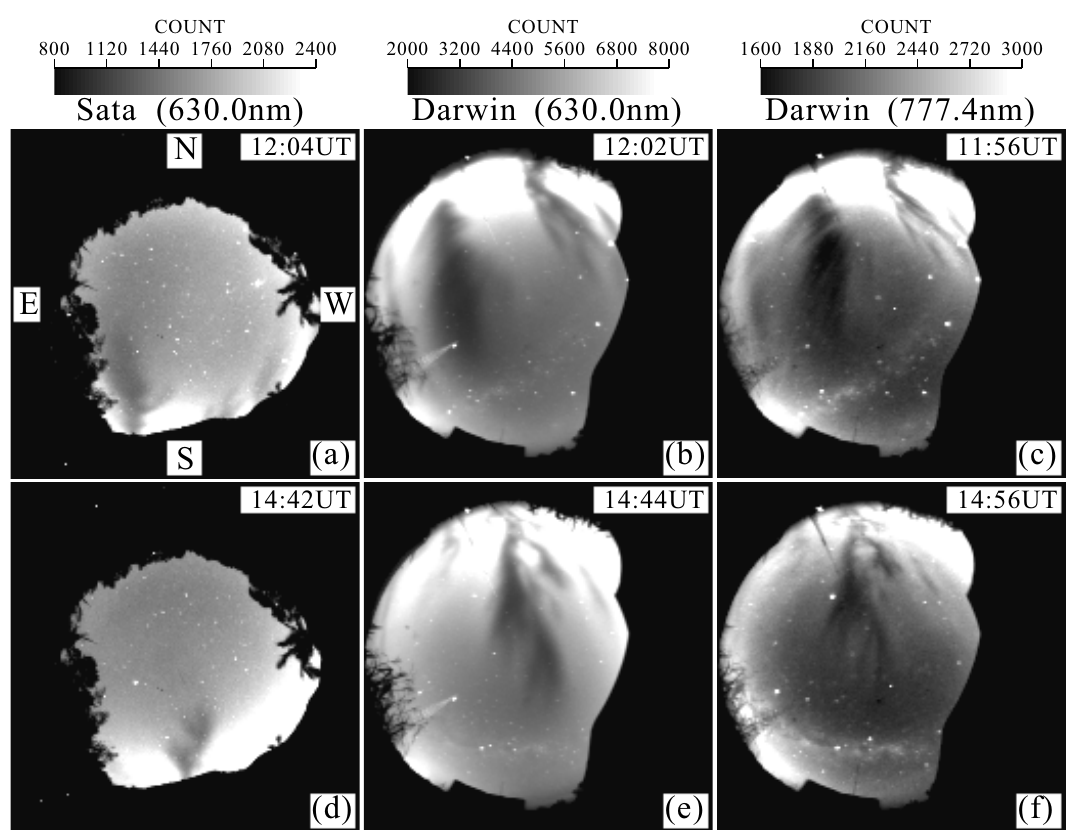
Fig. 1. All-sky airglow images at wavelengths of OI 630.0nm and OI 777.4nm observed at ( a ) and ( d ) Sata, Japan and ( b ) , ( c ) , ( e ) , and ( f ) Darwin, Australia, on 4 April 2002. Local time of these stations is UT +9h. The bubble structures (tree-like depletions of airglow intensity) are extended from south to north at Sata and from north to south at